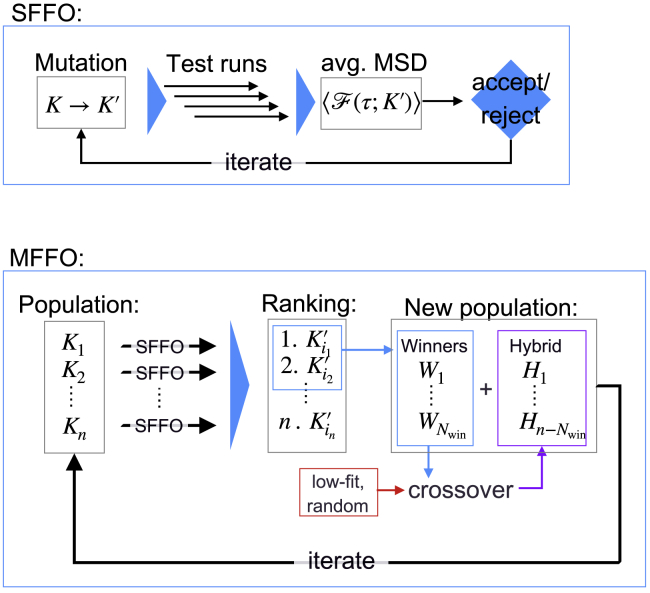
Schematic illustration of the SFFO and MFFO algorithms. To see this figure in color, go online.